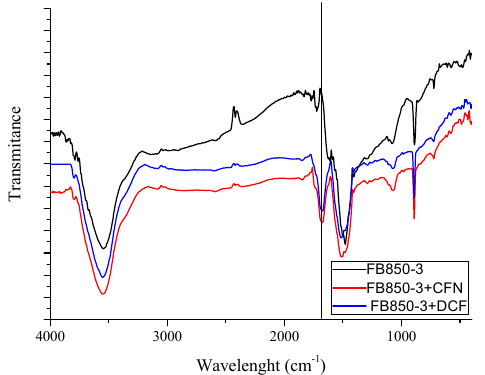
Figure 6. Infrared spectrum of FB850-3 prior to and post adsorption of CFN or DCF.